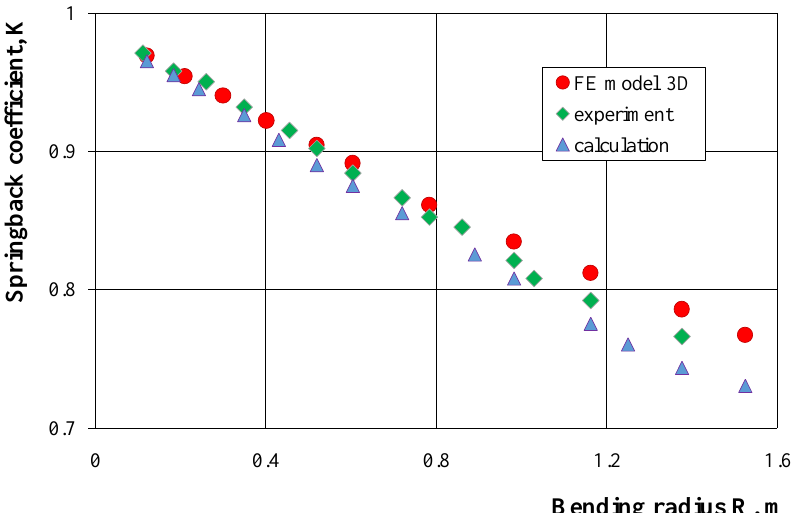
Figure 5. Comparison of the springback characteristics of a square tube with the dimensions of 25 × 25 × 2.5 mm determined on the basis of the results of experimental tests and two FE models.